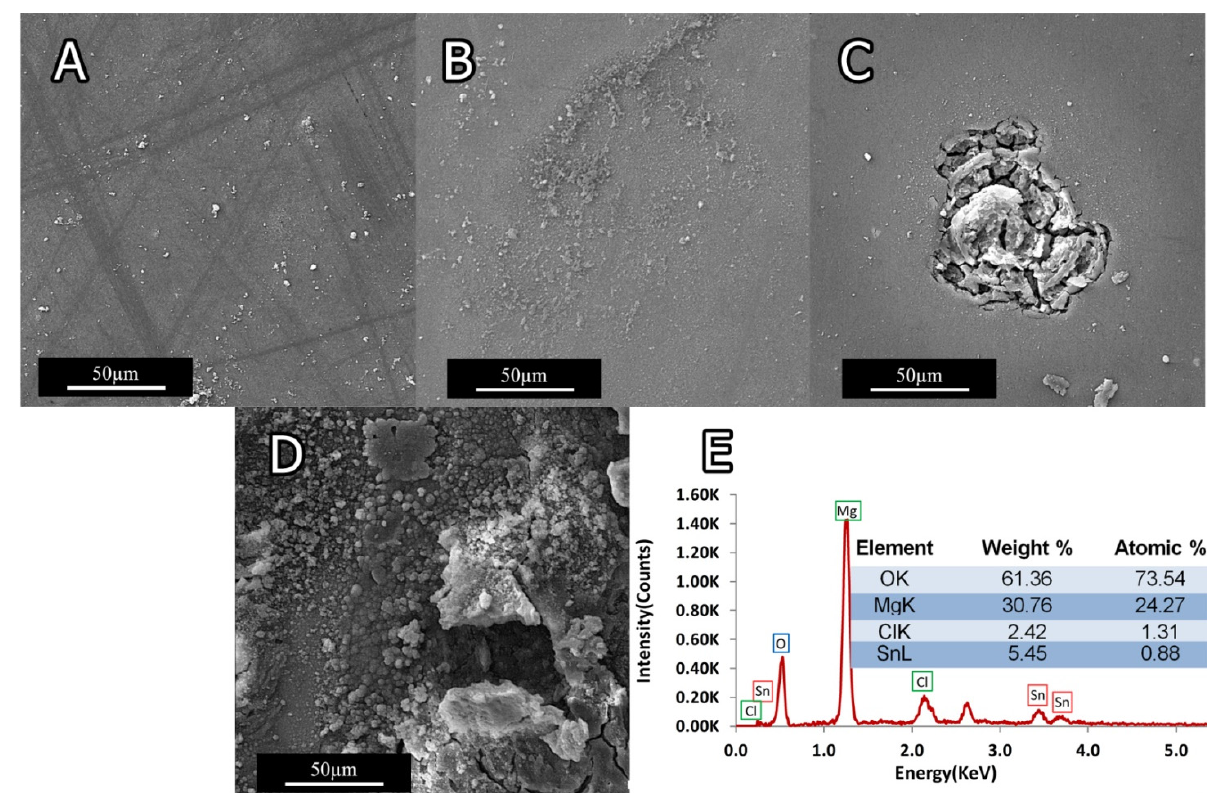
Figure 15. SEM micrographs of sample’s surface after immersion in 3.5 wt.% NaCl solution: ( A ) 0Ti after 10 min immersion; ( B ) 0Ti after 2 h immersion; ( C ) 1.5Ti after 10 min immersion; and ( D ) 1.5Ti after 2 h immersion. ( E ) The corresponding EDS analysis.